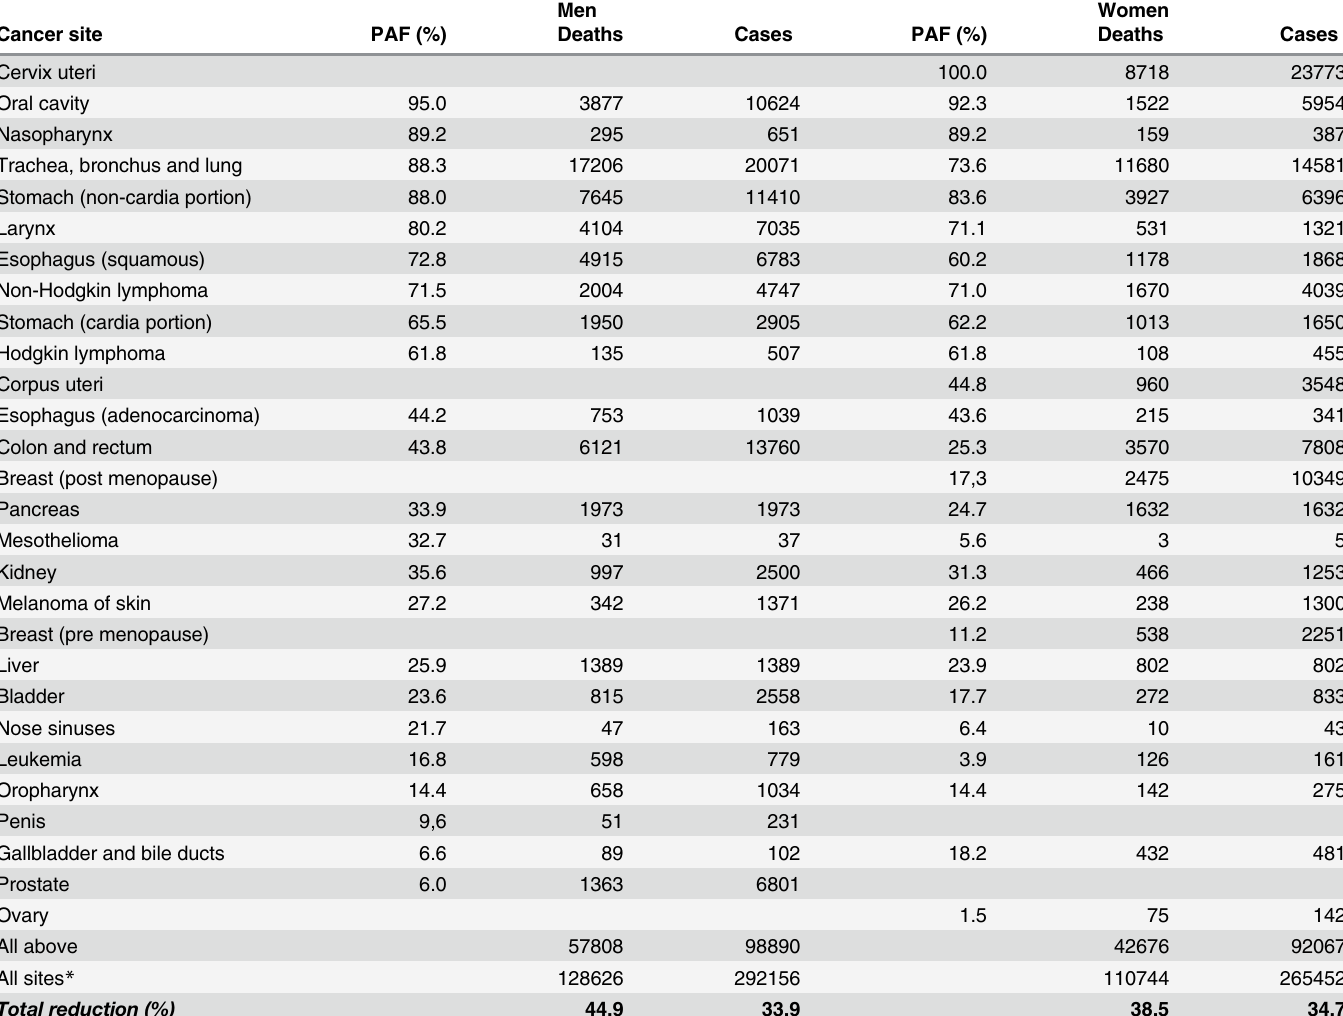
Table 2. Population-attributable fractions (PAF) and corresponding estimates for 2020 of deaths and cases by cancer site for the population 30 years old and over in Brazil by